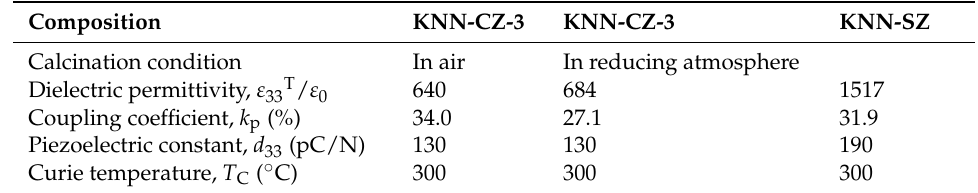
Table 9. Piezoelectric properties of single ‐ layer disk samples (measured temperature: 25 °C).